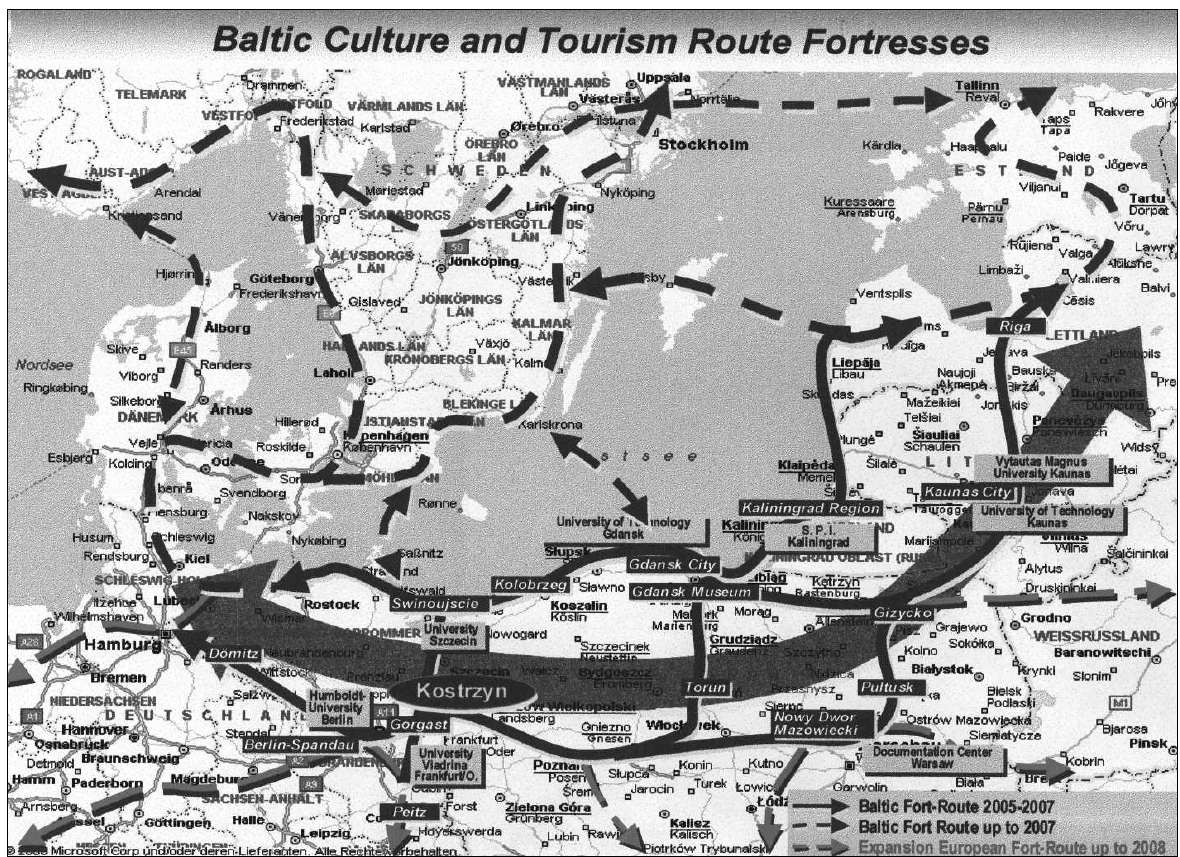
Fig. 1. Scheme of planned Baltic Fort